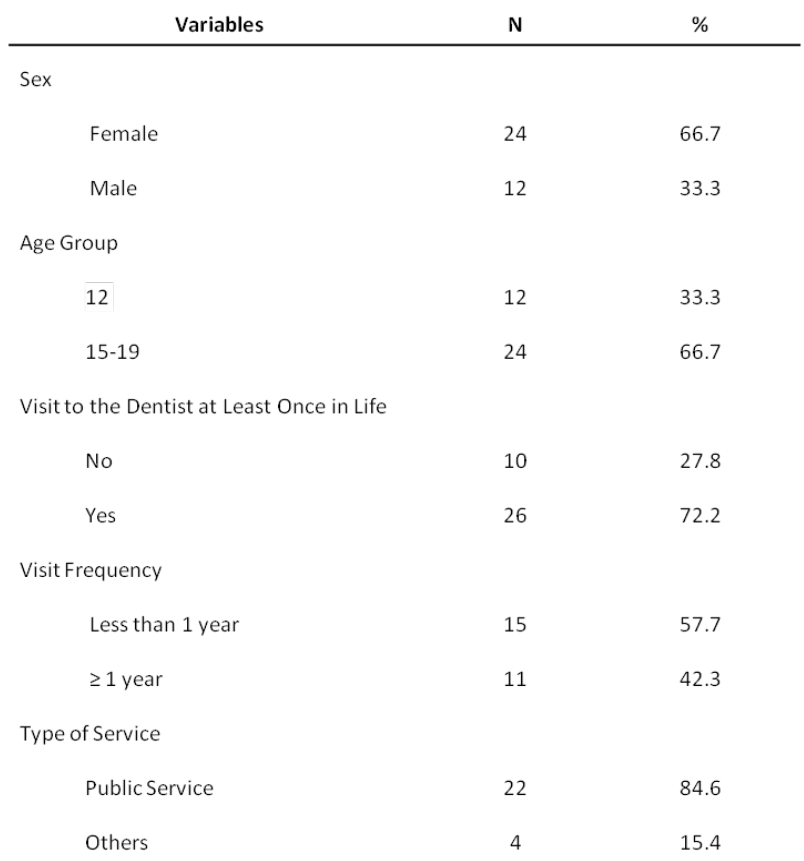
Table 1. Distribution of sociodemographic variables of Quilombola